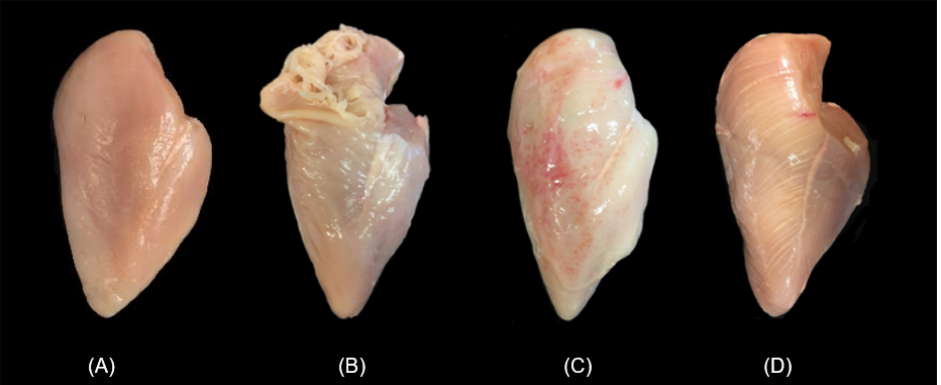
Figure 5. Myopathies in young broilers showing a normal fillet ( A ), spaghetti meat ( B ), the so-called woody-breast ( C ), and a fillet with white striping ( D ). Images by S. Barbut Lab.